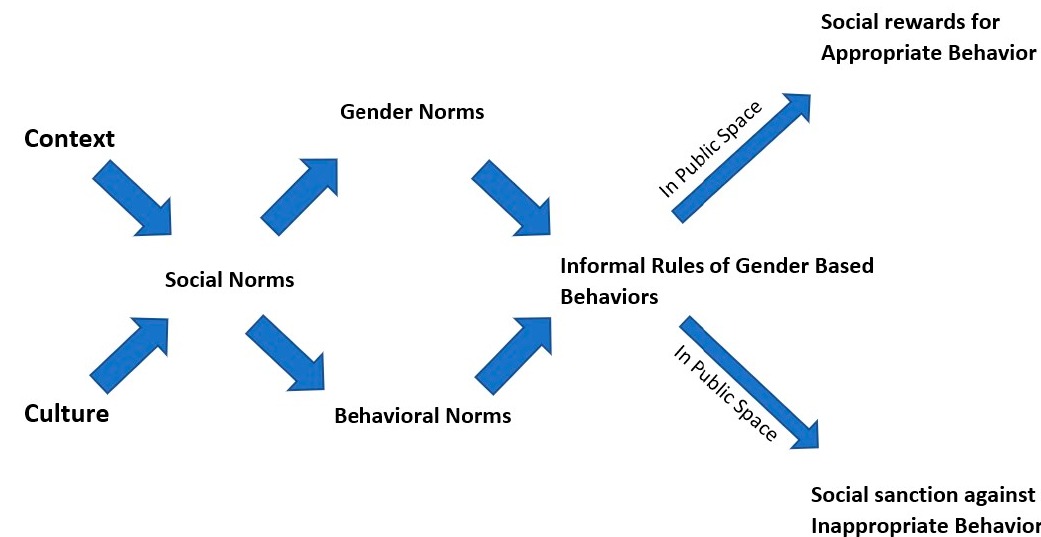
Figure 1. A diagram of how appropriate behaviors are reinforced for men and women according to current social norms. Adapted from Shaffer and Kipp [91].